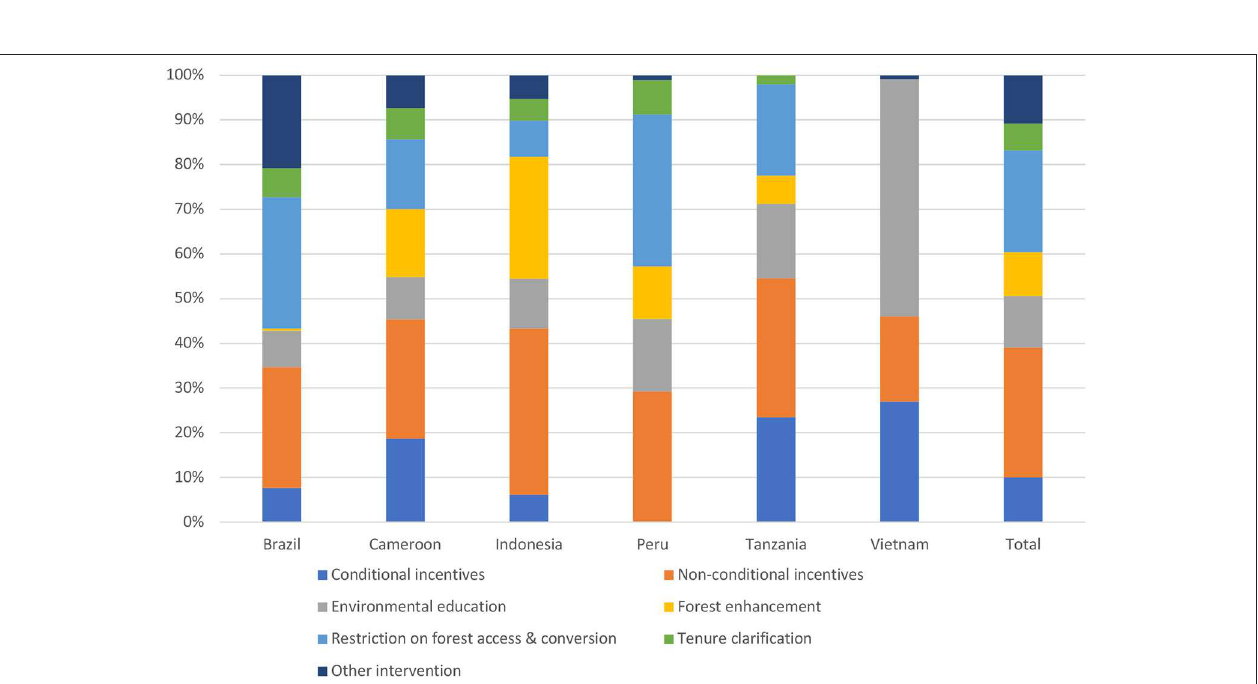
FIGURE 7 | Household-reported involvement in tools of subnational REDD + interventions. Includes only cases where the household is actually involved in the intervention (“involved” = “yes”). Source: GCS-REDD M2 data, household surveys, 2013–2014.